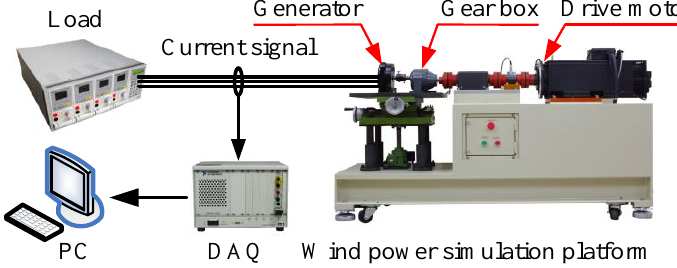
Figure 6. The block diagram of wind power simulation platform.